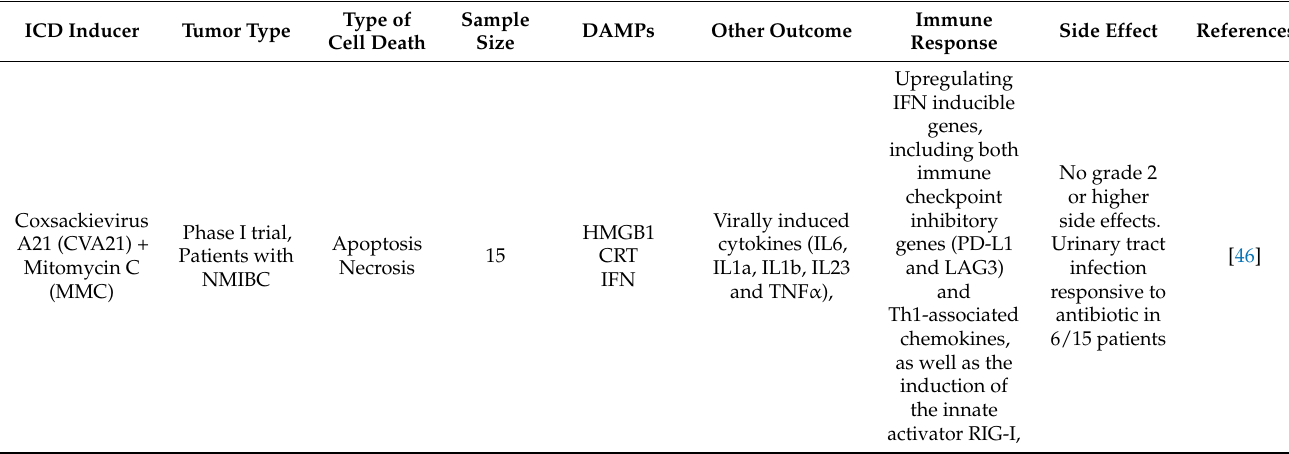
Table 2. Overview of clinical trials involving ICD inducing